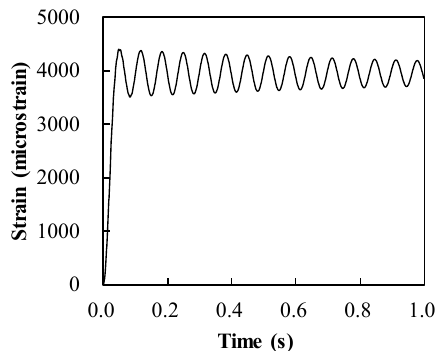
Figure 14. Strain evolution in steel of the optimized hybrid system containing 8.2 mm thick steel slab and 7.0 mm thick ϕ 100 mm CFRP frame.